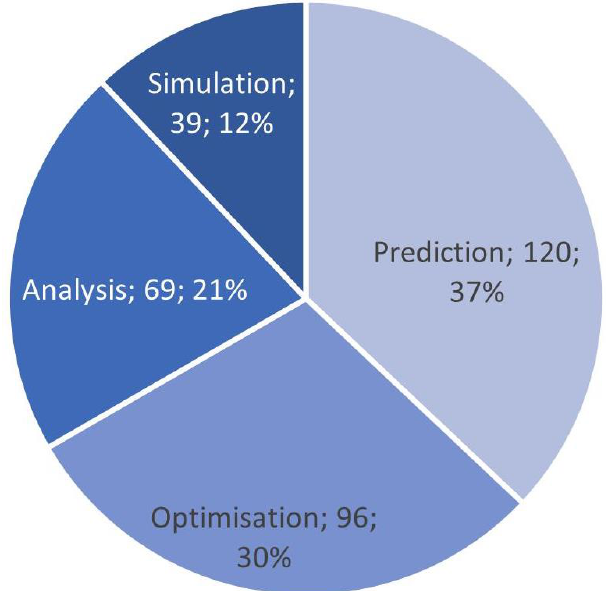
Figure 8. Evolution of the number of publication per year of the Prediction, Optimisation/Automation, Modelling/Simulation, and Analysis categories.